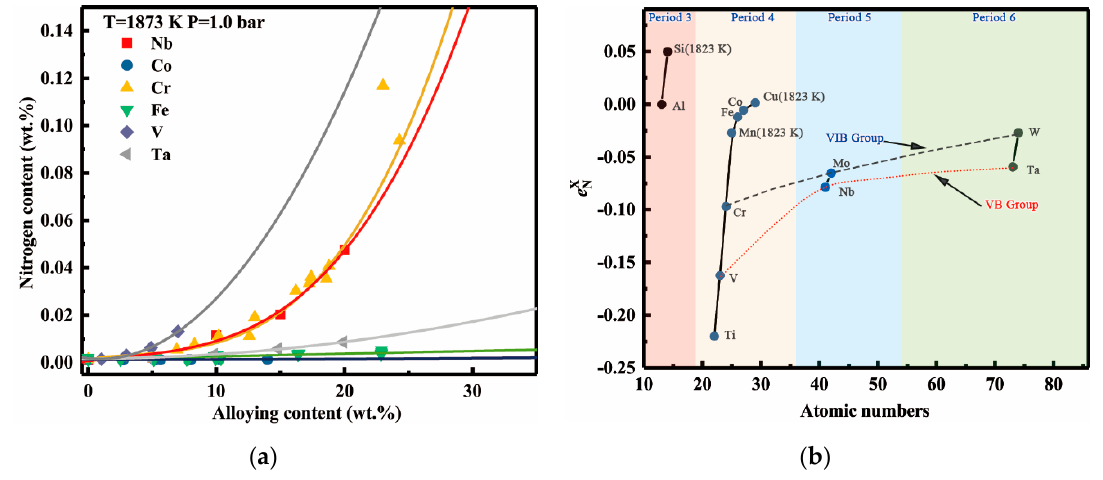
Figure 10. ( a ) Effect of alloying elements content on the nitrogen solubility in liquid nickel at 1873 K; ( b ) Relation between atomic numbers and values of the interaction parameter e X 1873 K.